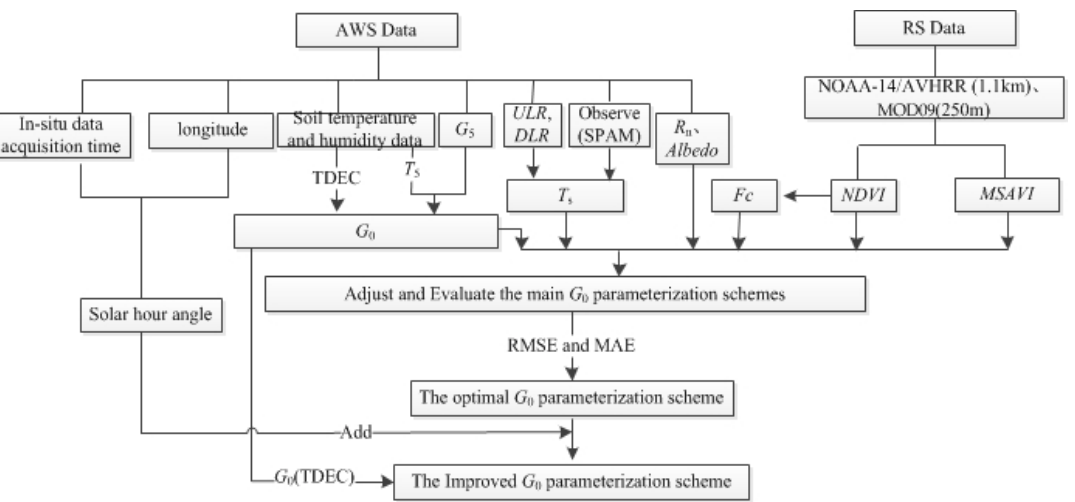
Figure 2. Flow chart of the of optimizing process for G 0 parameterization scheme